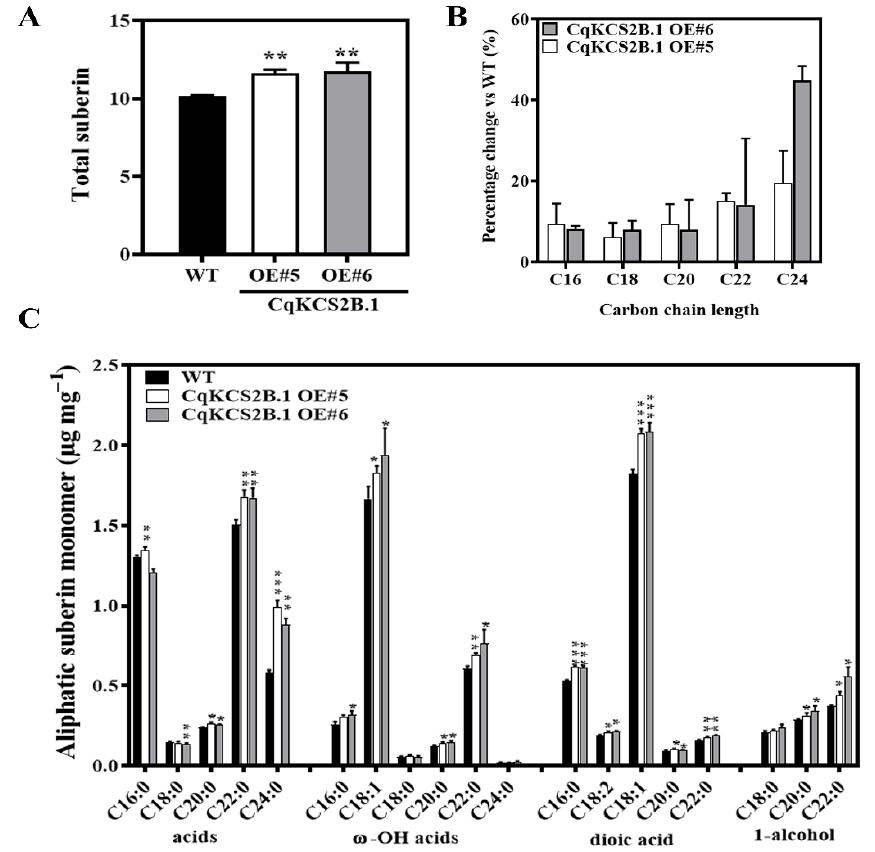
Figure 6. Gas chromatographic analysis of aliphatic suberin monomers and endodermal suberin in roots of transgenic Arabidopsis and WT (Col-0). ( A ) Total suberin content in roots of 4-week-old CqKCS2B.1 OE#5, OE#6, and WT plants. ( B ) Distribution of aliphatic monomers of suberin according to chain length. ( C ) GC-MS results grouping fatty acids in WT and OE lines according to chain length, saturation status, and presence of ω -OH acid, dioic acid, and 1-alcohol additions. Values are mean ± SD. *, ** and *** indicate significant differences between OE lines and WT at p < 0.05, p < 0.01, and p < 0.001 respectively (Student’s t -test).